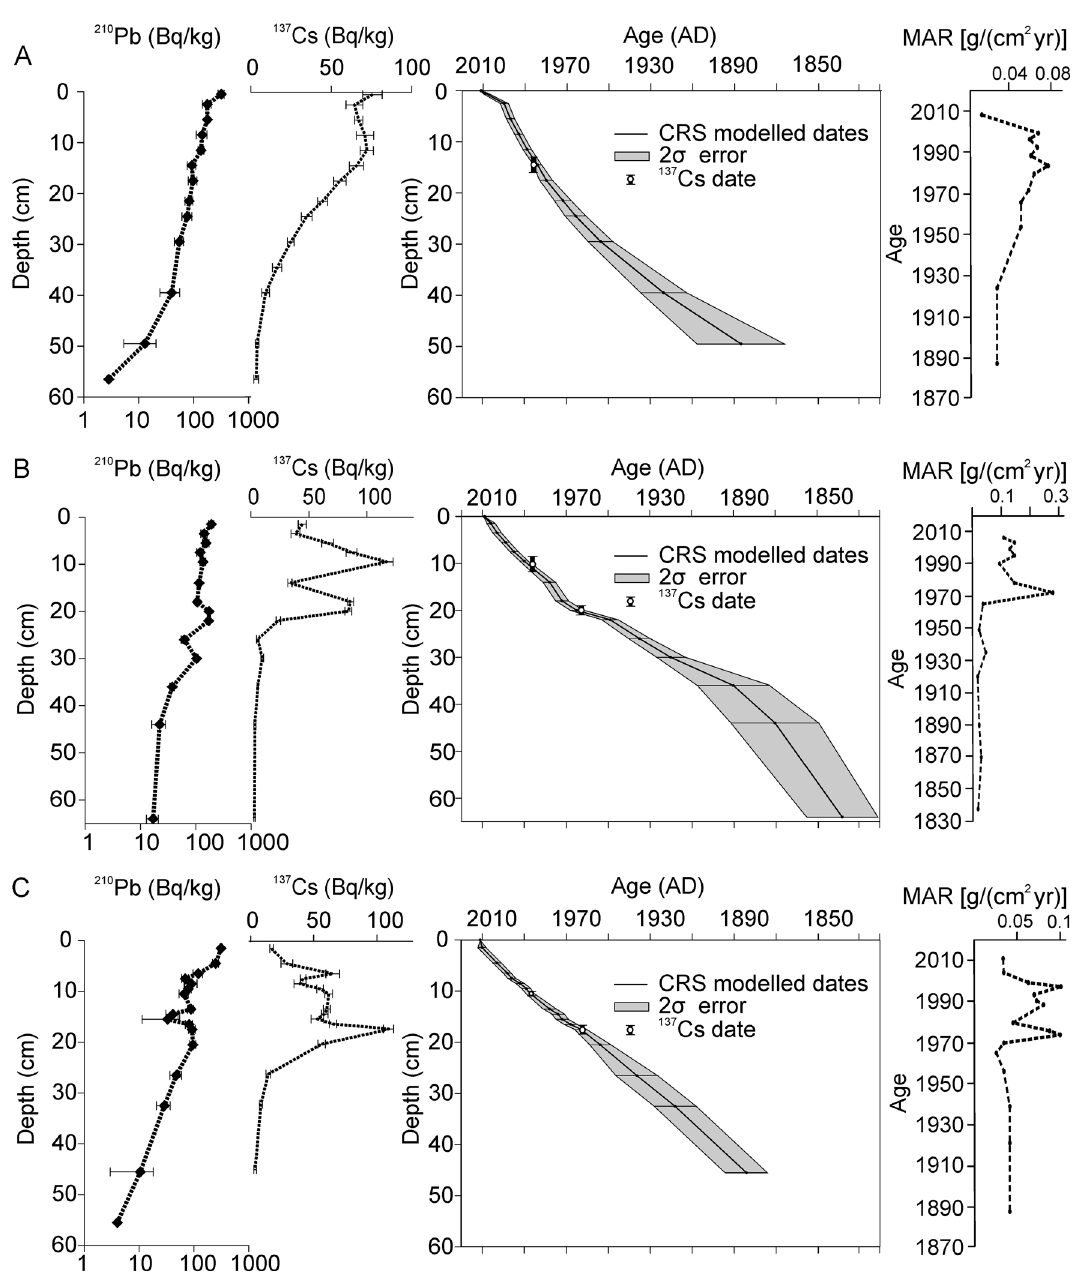
Fig. 2. Activity profiles of 210 Pb and 137 Cs versus depth in sediments from the studied lakes ( A , Lake Lohja; B , Lake Nõmmejärv; C , Lake Verevi). Age–depth diagram with modelled 210 Pb dates. Black squares represent 210 Pb dates from the revised CRS model fitted to the 137 Cs peak (white circle). MAR – mass accumulation rate in the studied